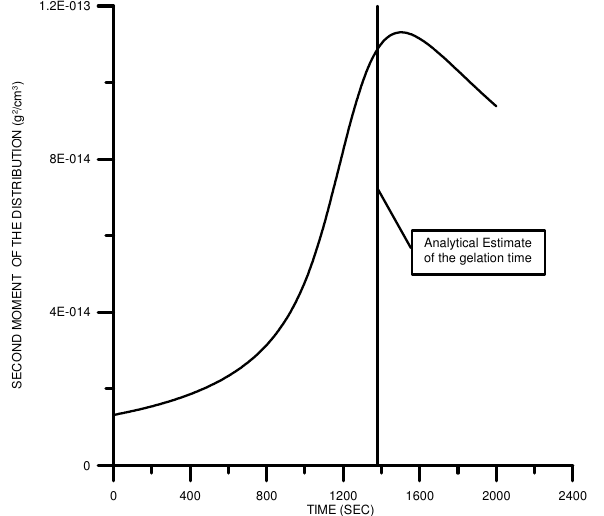
Fig. 7. Time evolution of the statistics STD (M L 1 ) (thick solid line) estimated for 1000 realizations of the Monte Carlo al- gorithm and the results of the Z-test (thin solid line with crosses). The simulations were performed for the hydrodynamic kernel with a bidisperse initial condition N( 1 ; 0 ) = 50 and N( 2 ; 0 ) = 50.